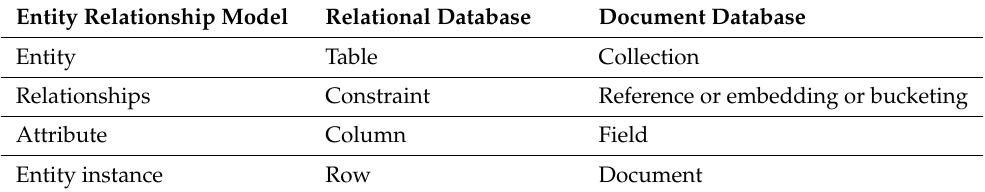
Table 2. Mapping concepts between relational databases and document